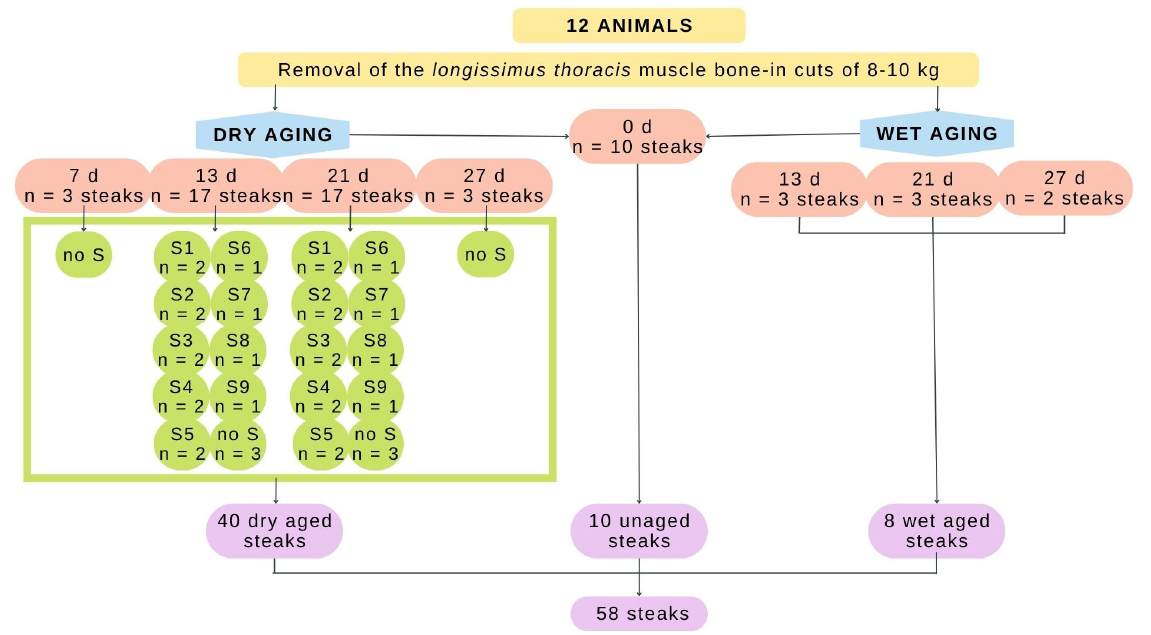
Figure 1. Distribution of the samples utilized for this study according to the type of aging method, time, and starter used. S1, S2, S3, S4, S5, S6, S7, S8, and S9 represent the dissimilar starters and “no S” refers to non-inoculated beef.